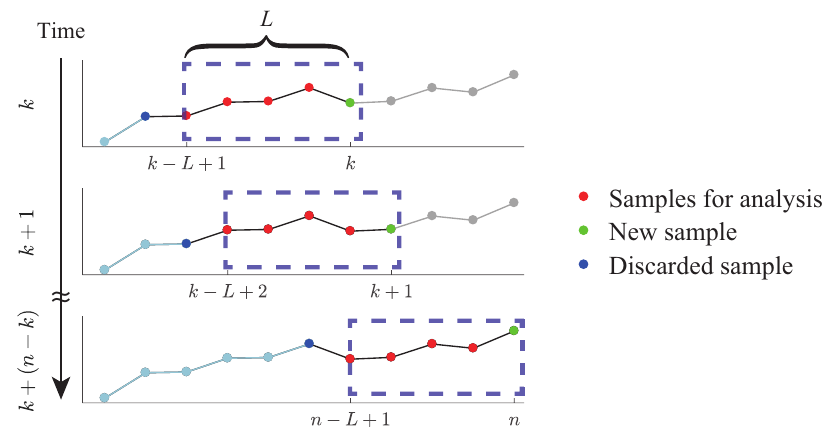
Figure 1. Diagram of the sliding-window analysis (SWA). Samples placed in the sliding-window, including the newest sample, are applied signal processing or used for analysis. A sliding-window will move to the next when the time instant k is